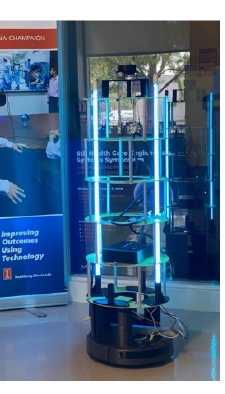
Figure 11. UVBot disinfection test in a corridor. (1–3) Progression of the UVBot in this environment. The overall disinfection took 1119 s, with a total travel length of 35 m. The average disinfection speed was 3.13 cm/s, which meets the speed requirement we calculated from the virus experiment. In the wall-following process, the bumper-based control was in- volved a few times when the UVBot tried to pass a trash bin, showing that our wall-fol- lowing algorithm is reliable. The performance of the wall-following algorithm can also be indirectly observed from the actual working speed because the actual speed was close to our default wall-following speed (3.15 cm/s) and the bumper-based control significantly slowed the UVBot. The robot trajectory in the map formed a perfect loop, which demon- strates the superior behavior of the SLAM algorithm. The office environment was a small office cubicle, as shown in Figure 12. After the disinfection process started, we saved the map, as shown in the bottom-left subplot of Figure 12. Next, we loaded the map and added a virtual wall to prevent the UVBot from moving under the desk. The virtual wall is shown in green lines in the top-right and top- bottom subplots of Figure 12. When the UVBot moved into the 400 mm region of the vir- tual wall, instead of following the real walls (black pixels in the subplots), it followed the custom virtual wall. The disinfection test results for the office cell show the saved map, loaded map, and edited map functions, as well as the performance of the UVBot following a virtual wall. The time to disinfect the office cell was 120 s, with a travel distance of 3.6